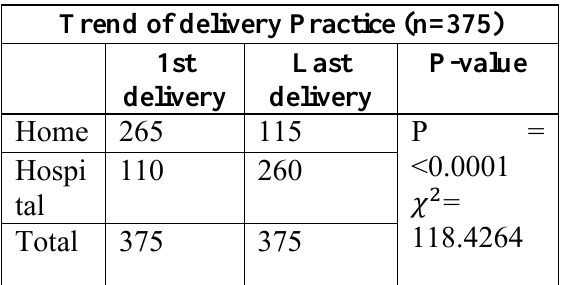
Table 3. Traditional practice of Rajbanshi as first choice by urban-rural